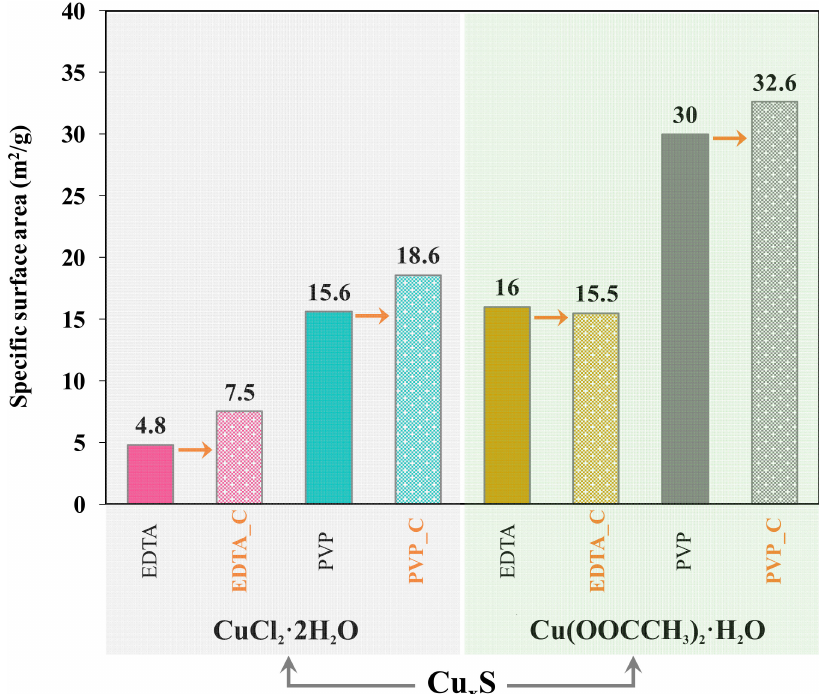
Figure 7. Brunauer–Emmett–Teller (BET) specific surface areas of the Cu x S